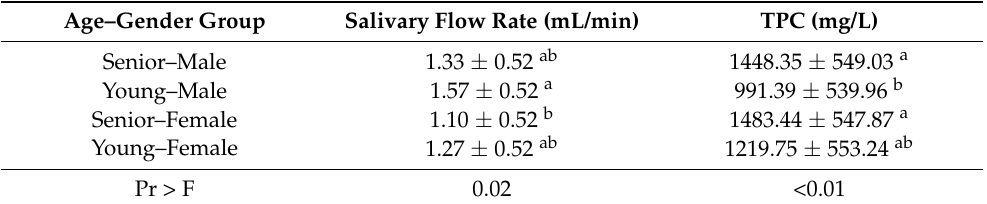
Table 1. ANOVA and Tukey test results of saliva characterization by age–gender